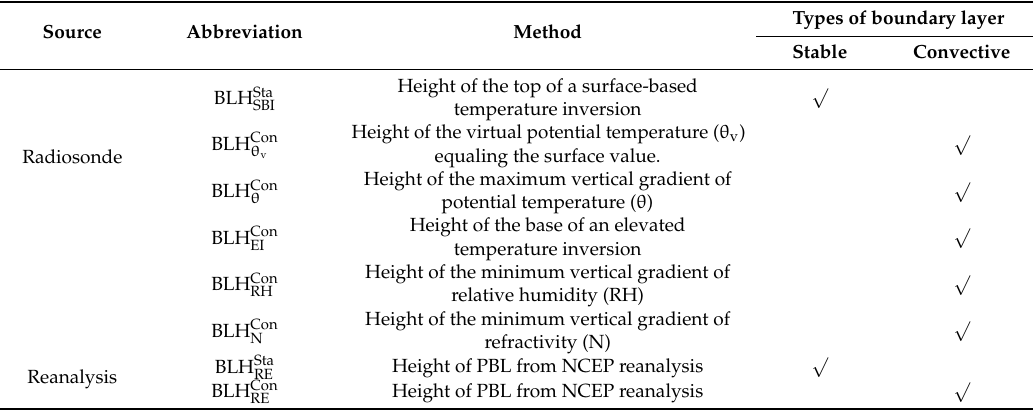
Table 1. Seven methods for estimating boundary layer height